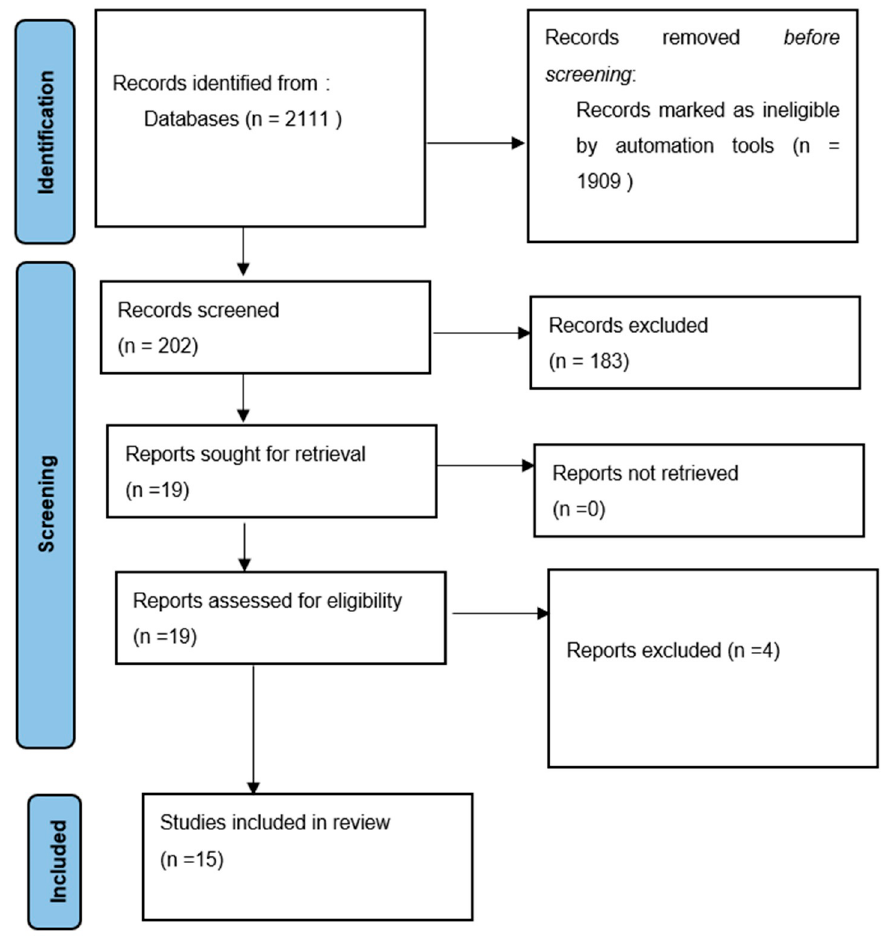
Figure 1. Flowchart summarizing the article selection process (n—number of studies).